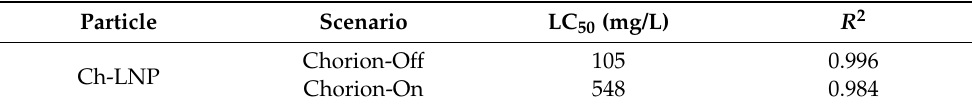
Table 2. Calculated LC 50 values at 120 hpf for Ch-LNPs in both experimental scenarios.